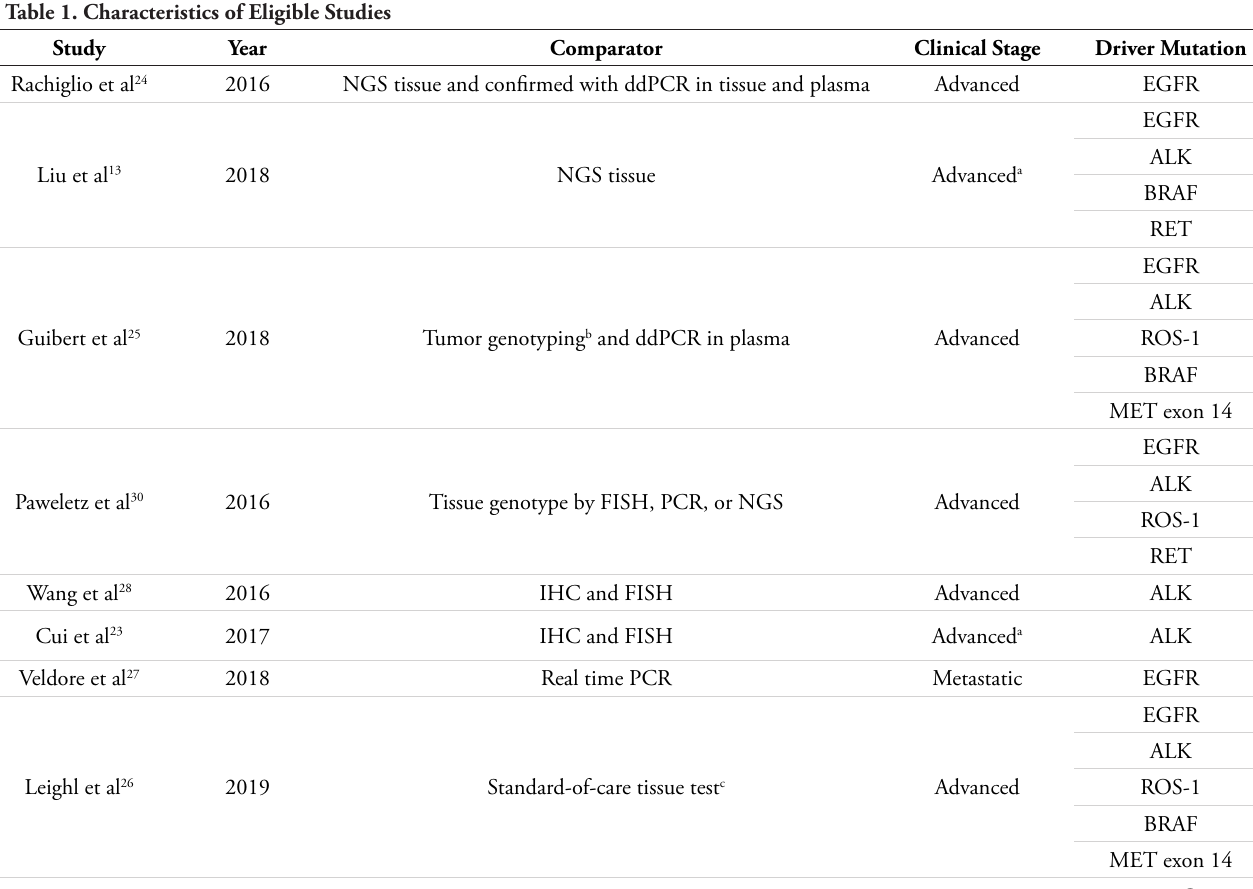
Table 1. Characteristics of Eligible